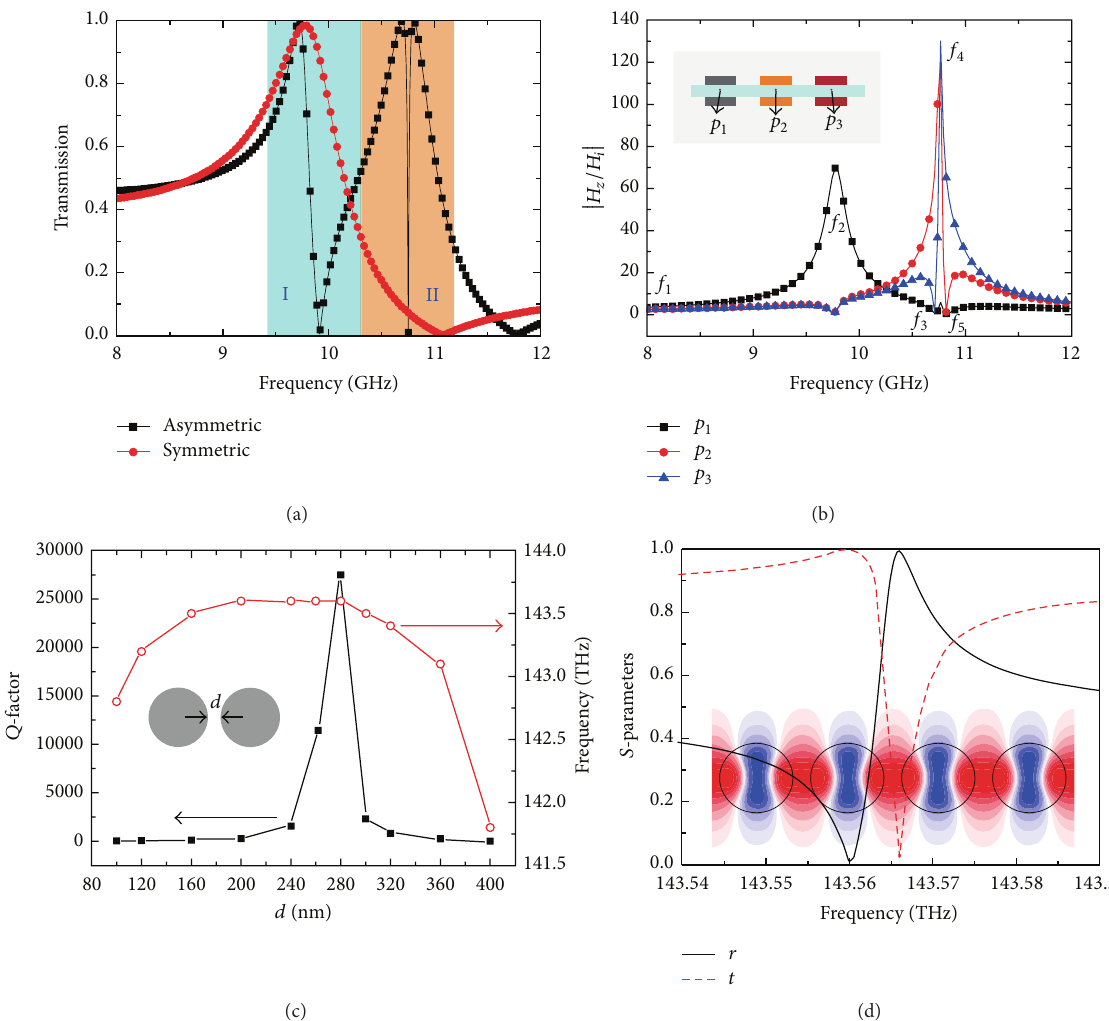
Figure 5: (a) Transmission coefficients for the symmetric and asymmetric metasurface slabs. Region I shows typical asymmetric line shape of Fano resonance. Region II demonstrates the ultrasharp resonance peak induced by interelement coupling. (b) Normalized magnetic fields (Hz) at the center of these resonators. The inset shows the unit cell and the points where the magnetic fields are extracted. (c) Quality factor of a cylinder array. (d) Scattering parameters of this array. Inset shows the distribution of the electric fields at resonant frequency. Figures are reproduced from (a, b) [19] and (c, d)